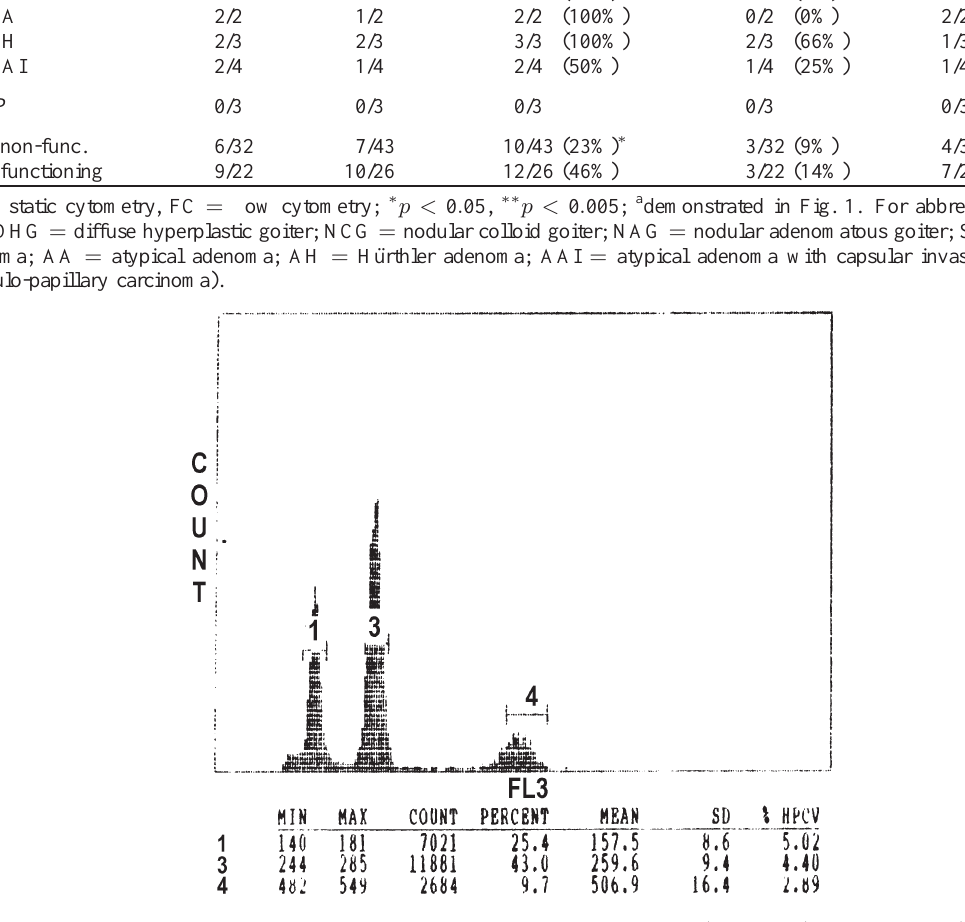
Fig. 1. Flow cytometry of case no. 41 of a biclonal H¨urthler adenoma. A diploid (2c, peak 1) and aneuploid (3.4c, peak 3) clones; peak 4 is the G2M